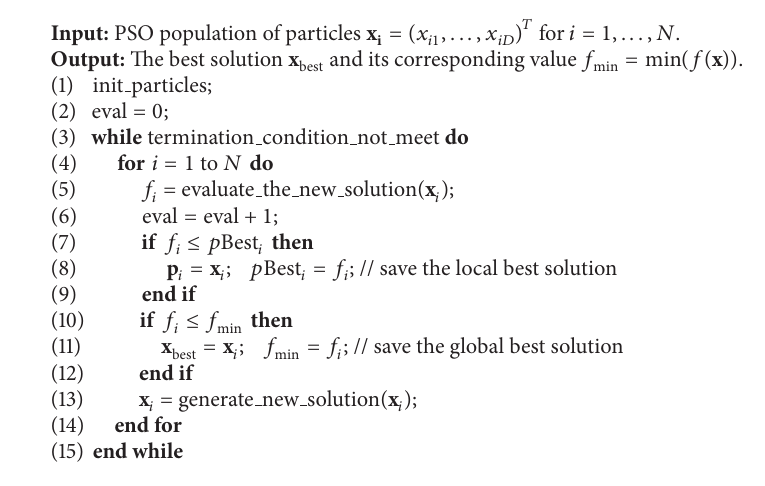
Algorithm 1: Pseudocode of the classic PSO algorithm.